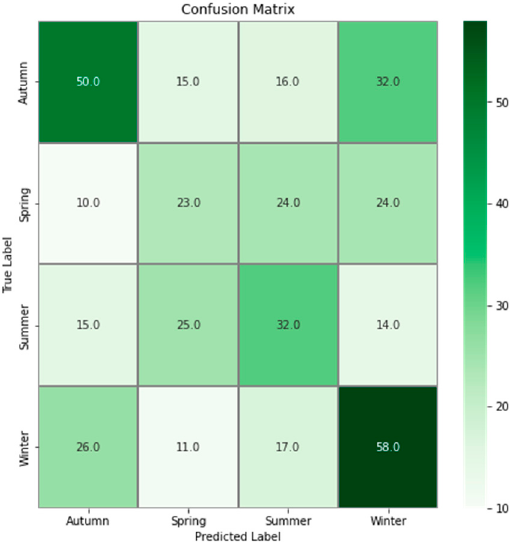
Figure 3. Confusion matrix of classification between seasons. For a given element, the value corresponds to the number of drawings predicted as the label matching with the column but belonging to the label matching with the row.